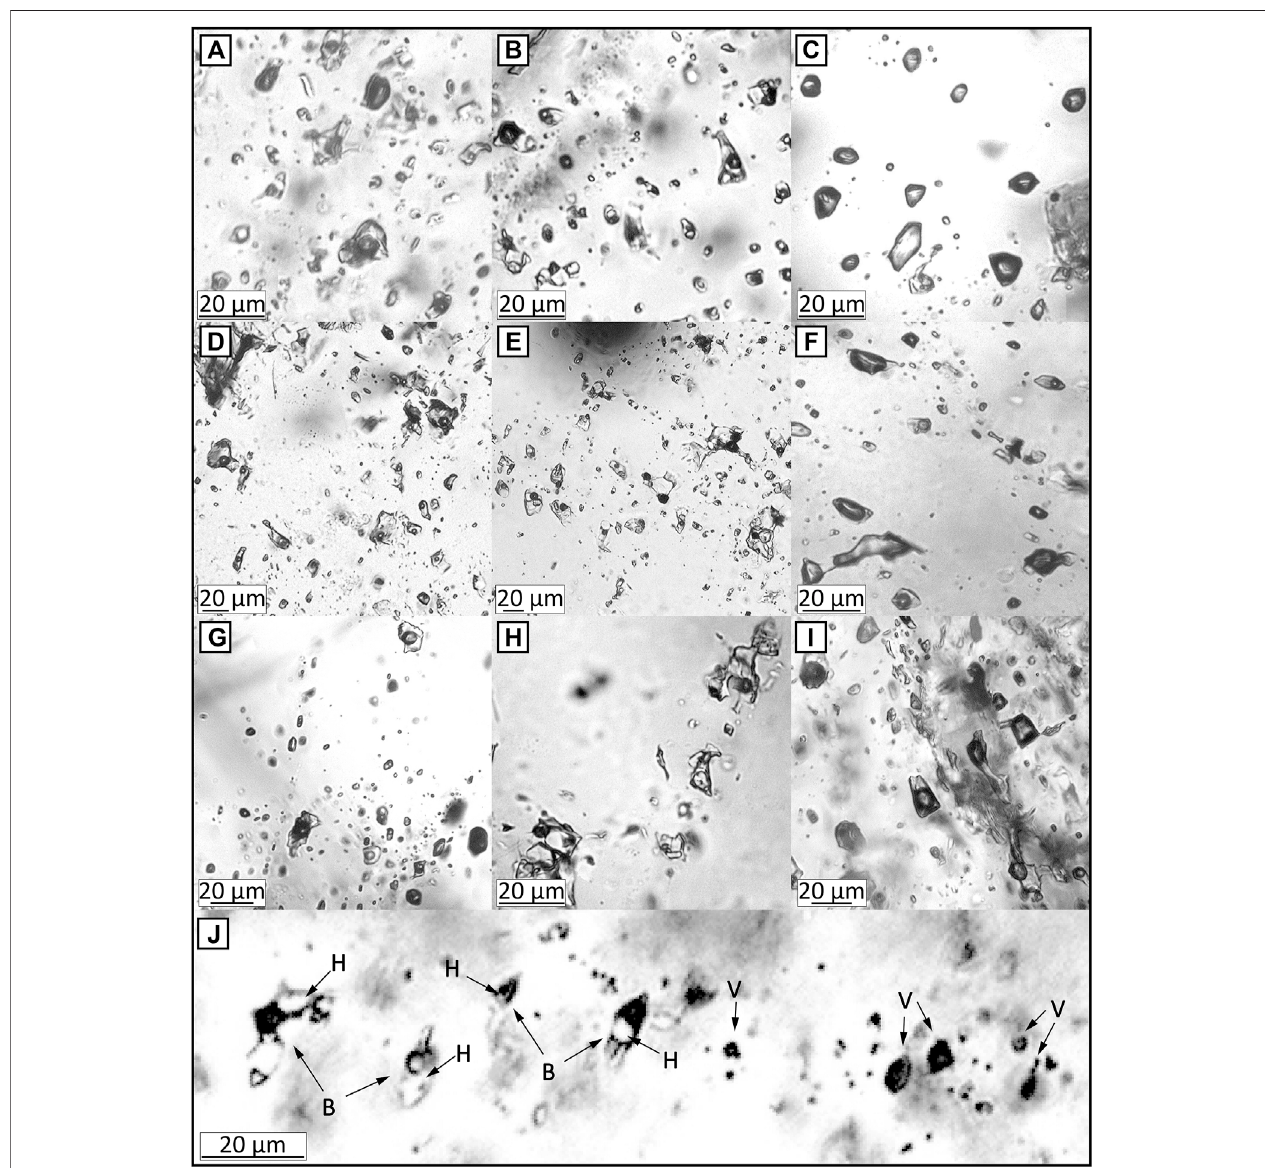
FIGURE 7 | Types of fl uid inclusion assemblages in mineralized quartz veins. (A) liquid inclusions, (B) brine inclusions, and (C) vapor inclusions in the Haman deposit. (D) liquid inclusions, (E) brineinclusions, and (F) vaporinclusionsintheGunbuk deposit. (G) liquid inclusions, (H) brineinclusions,and (I) vaporinclusionsinthe Daejang deposit. (J) The brine and vapor inclusions in the boiling assemblage in the Daejang deposit. B, V, and H represent brine inclusion, vapor inclusion, and halite, respectively.Mostofthe fl uidinclusionsobservedinthestudieddepositswereeitherliquidinclusionswithabubblesizeofaround20vol%orbrineinclusionswitha bubble size of 10 – 30 vol%. Minor vapor inclusions with bubble sizes of 70 – 80 vol% were also observed.